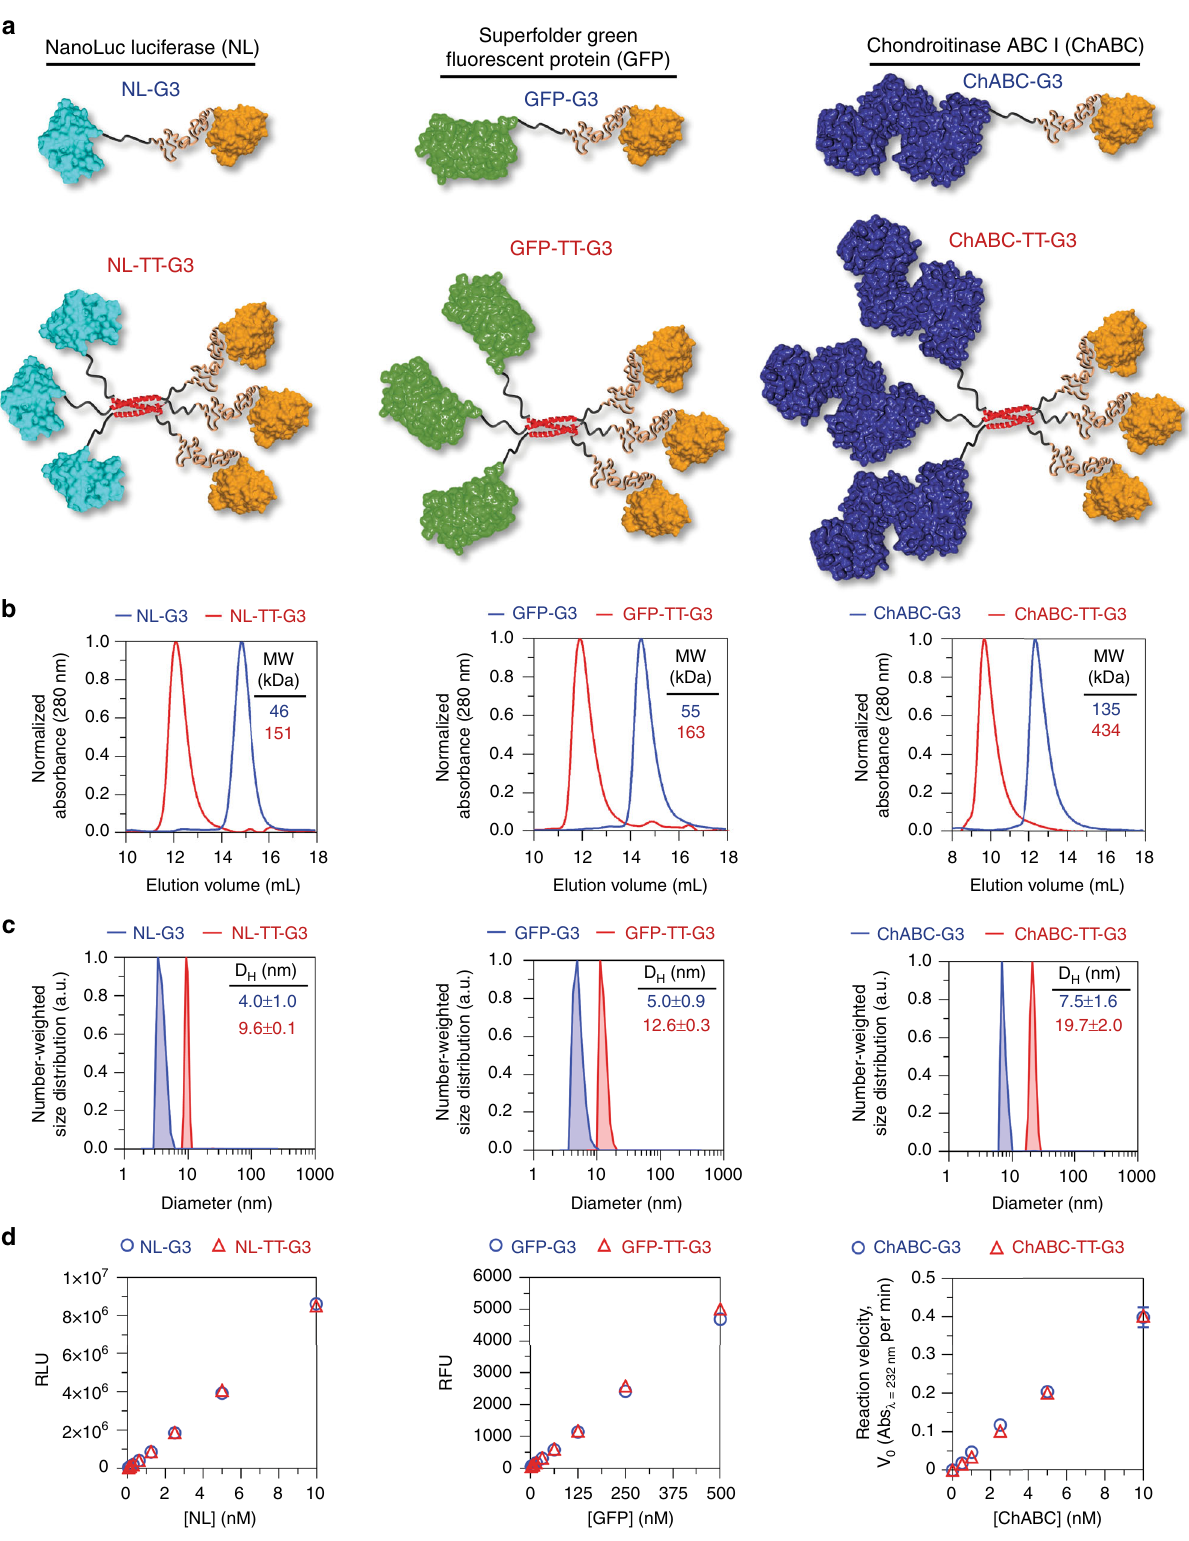
Fig. 2 Design and characterization of monomeric G3 fusion proteins and trimeric nanoassemblies. a Predicted structure of NanoLuc TM luciferase (NL), superfolder green fl uorescent protein (GFP), and chondroitinase ABC I (ChABC) monomeric G3 fusion proteins and trimeric nanoassemblies. b Approximate molecular weight determined under native conditions via size-exclusion chromatography. c Average hydrodynamic diameter estimated via dynamic light scattering. d Quantitative bioluminescence, fl uorescence, and reaction velocity of NL, GFP, and ChABC fusions, respectively. PDB ID: 5IBO [10.2210/pdb5IBO/pdb] (NanoLuc TM luciferase), 2B3P [10.2210/pdb2B3P/pdb] (superfolder GFP), 1HN0 [10.2210/pdb1HN0/pdb] (ChABC) for a . N ≥ 3, mean ± s.d. for c . N = 3, mean ± s.d. for d . Data for monomeric G3 fusion proteins appear as blue circles/traces, trimeric nanoassemblies as red